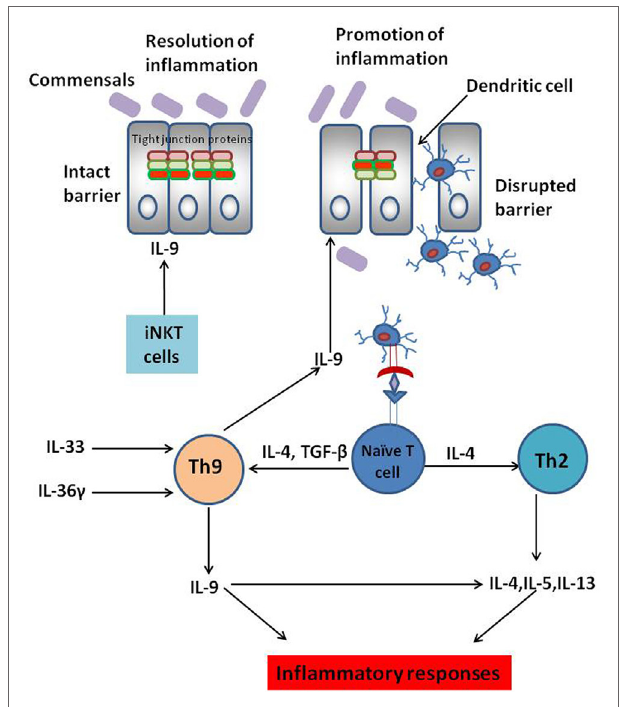
FigUre 1 | Complex role of IL-9-secreting Th9 cells in inflammatory bowel disease (IBD). Interleukin-9, a pleiotropic cytokine, is known to play dichotomous role in IBD. IL-9 secretion by Th9 cells disrupts intestinal barrier permeability resulting in the entry of innocuous antigens into the gut mucosa. This leads to antigen presentation by the dendritic cells to naïve CD4 + T cells culminating in T helper differentiation. Several cytokines are known to promote Th9 cell differentiation. IL-33 and IL-36 play a key role in Th9 cell proliferation in the gut mucosa culminating in